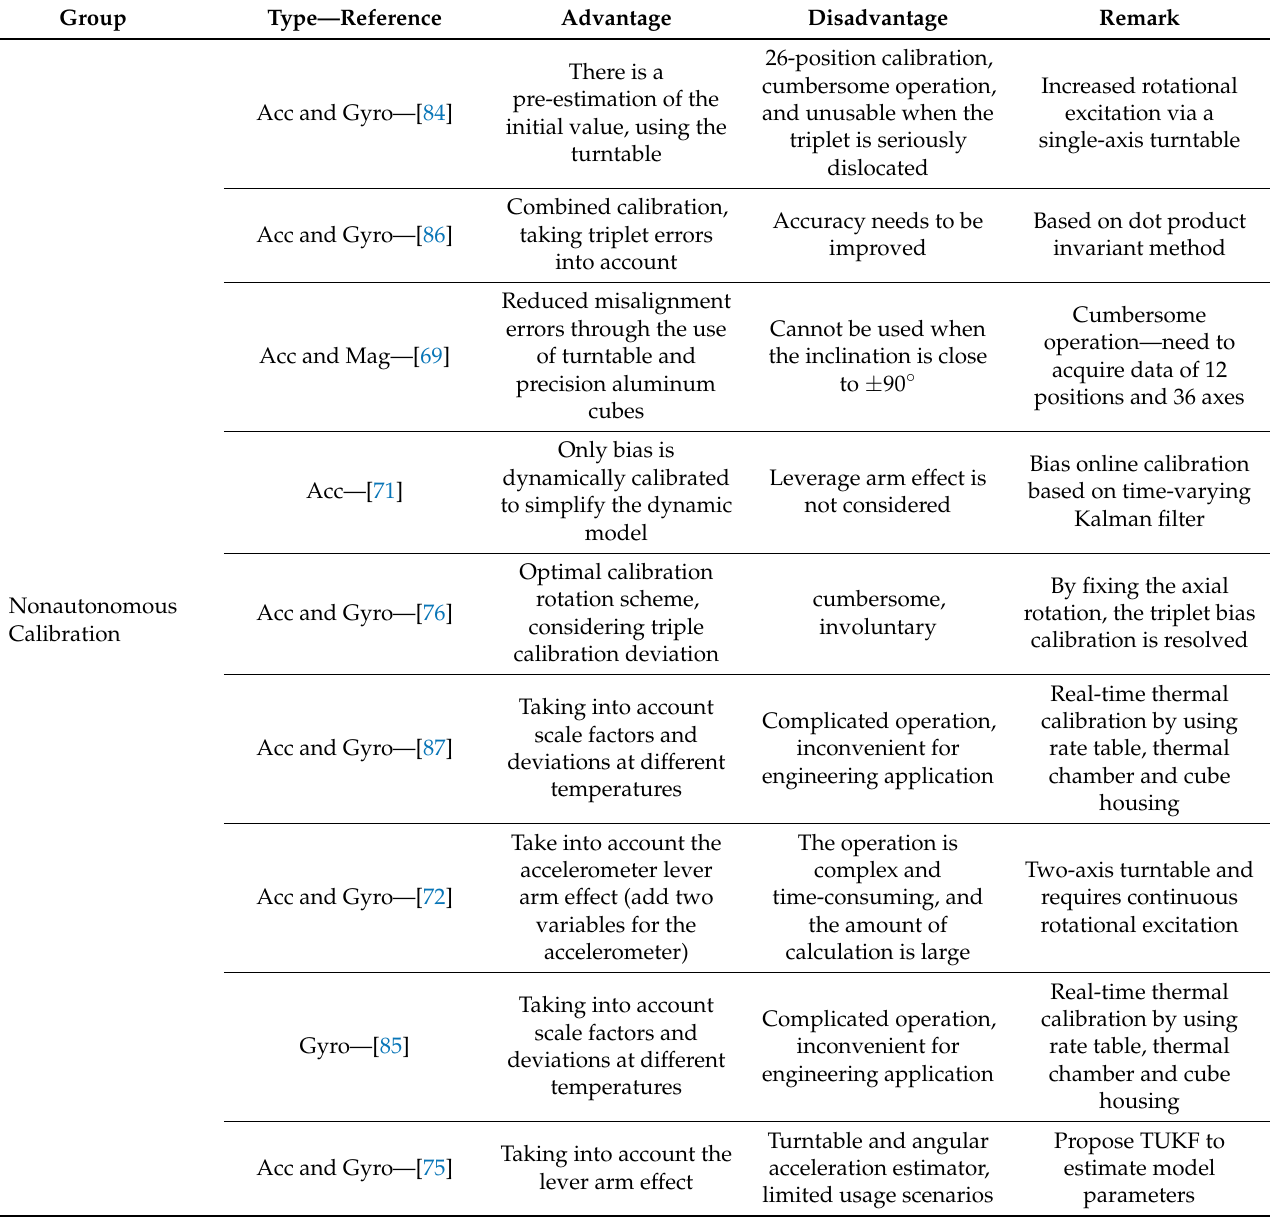
Table 4. Comprehensive overview of inertial sensor calibration methods. (Note: Acc—accelerometer; Gyro—gyroscope;